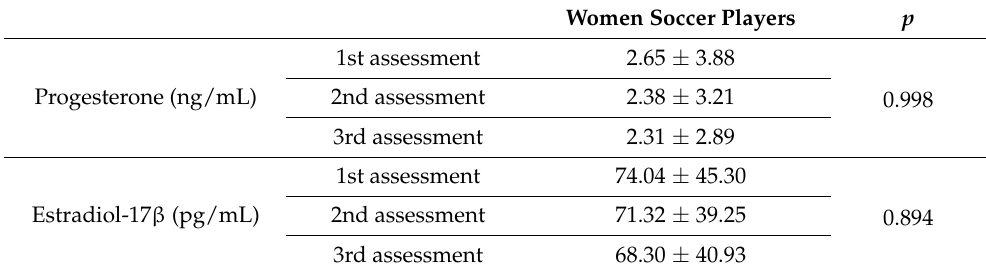
Table 8. Female hormones throughout the sports season.